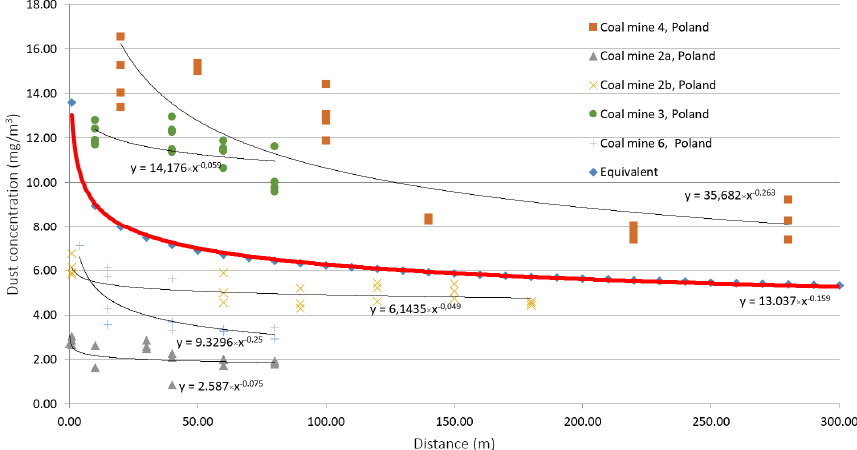
Figure 19. Equivalent characteristic of PM4 dust concentration (measured by CIP-10R dust meters) depending on the distance from a dust source, based on dust concentration measured in five coal faces.